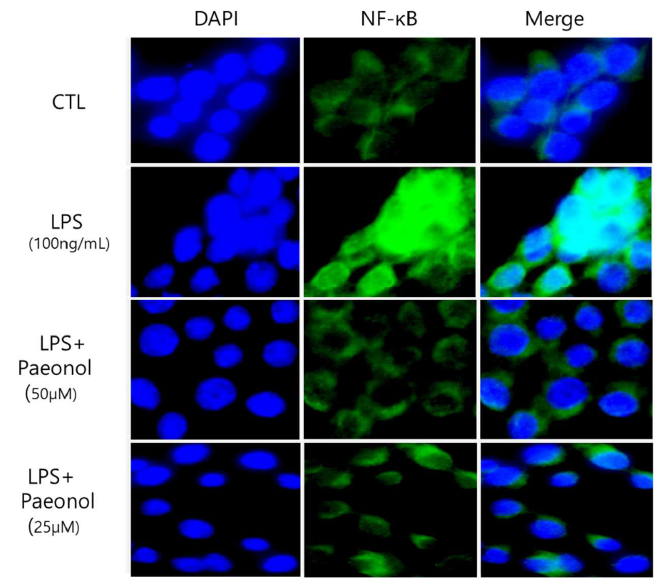
Figure 8. Effect of paeonol on pro-inflammatory NF-κB (nuclear) in LPS-activated RAW264.7 macrophages. RAW264.7 cells were pretreated without or with paeonol for 2 h at 37 °C. Then, the cells were treated with LPS for 22 h at 37 °C. LPS induced RAW264.7 cells were stained with NF-κB antibody (Alexa Fluor; green) for nuclear translocation and counterstained with DAPI (blue).